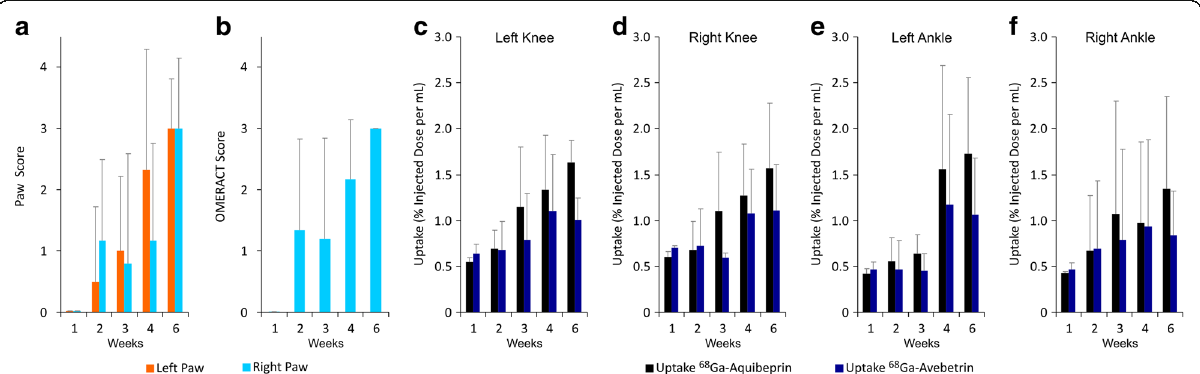
Fig. 1 Clinical scores and PET uptakes of mice developing a collagen-induced arthritis (CIA). a Average clinical RA scores for hind limbs, ranging from 0 = no symptoms to 4 = severe arthritis. b Average MRI-based synovitis scores for right ankle, scores according to EULAR-OMERACT RAMRIS ranging from 0 = no symptoms to 3 = severe synovitis. c – f Region-of-interest (ROI) based uptakes of the PET imaging agents 68 Ga-Aquibeprin ( α 5 β 1-integrin) and 68 Ga-Avebetrin ( α v β 3-integrin) in the left knee ( c ), right knee ( d ), left ankle ( e ), and right ankle ( f ). Data were generated for cohorts of 6 animals and are given as mean ±